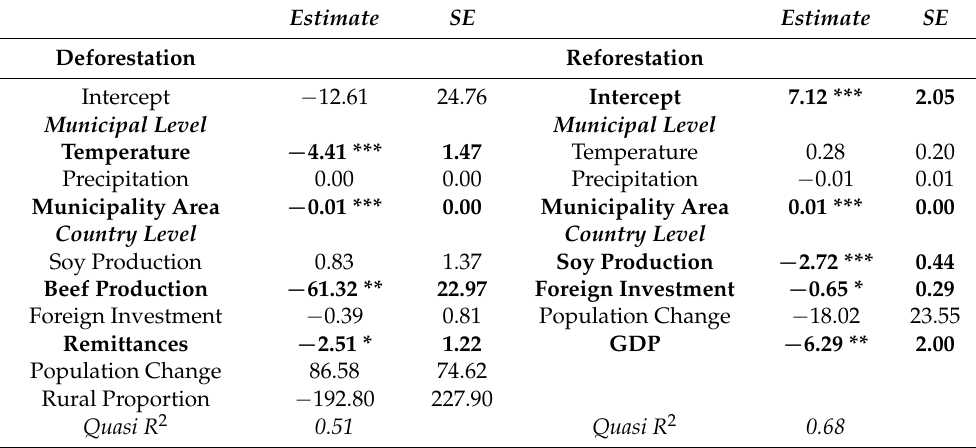
Table 1. Parameter estimates, and standard errors (SE) for best-fit models of deforestation and reforestation in LAC, excluding state- and biome-level predictor variables. Significant variable estimates are in